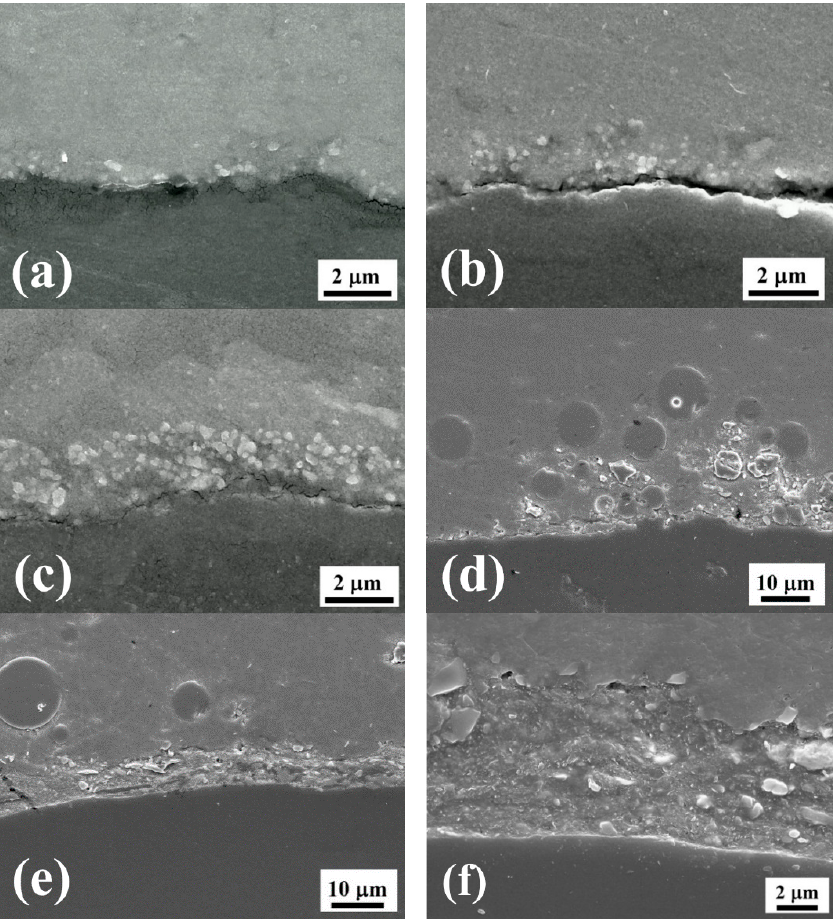
Figure 4. Typical cross-sectional SEM micrographs taken from samples: ( a ) 0.5 μ m Al 2 O 3 with 1 UMCA cycle; ( b ) 0.5 μ m Al 2 O 3 with 2 UMCA cycles; ( c ) 0.5 μ m Al 2 O 3 with 3 UMCA cycles; ( d ) mixed powders (15 μ m Al 2 O 3 + 15 μ m SiO 2 ) with 3 UMCA cycles; ( e ) mixed powders (15 μ m Al 2 O 3 + 15 μ m SiO 2 + graphite) with 3 UMCA cycles; and ( f ) enlarged micrograph of ( e ).